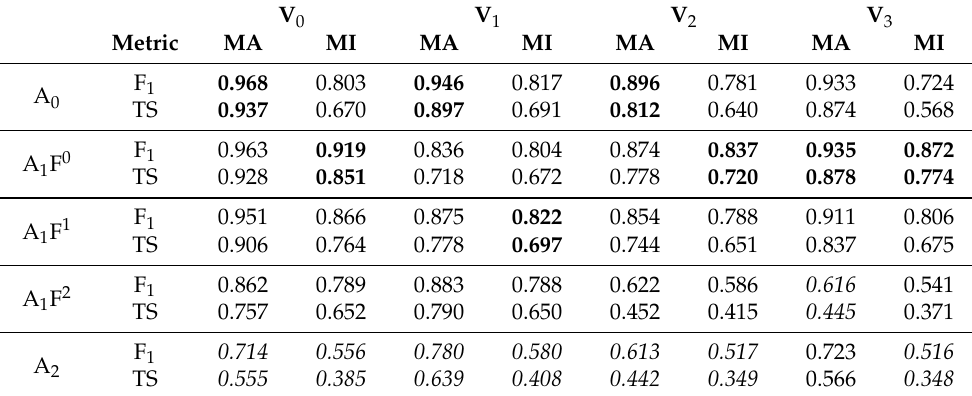
Table 6. F1 and TS metric results for all video/HPE-CNN combinations at the maximum tolerance threshold of 50 px. Bold: highest Italic: lowest column